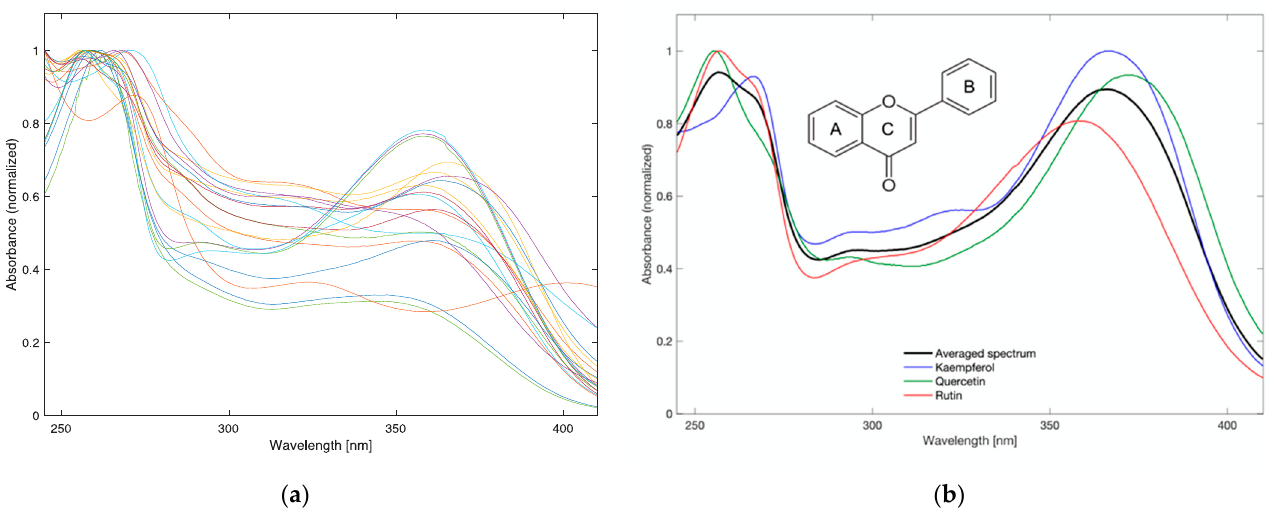
Figure 3. UV-Vis spectra of food supplements ( a ) and kaempferol, quercetin, and rutin ( b ) in 80% methanol.